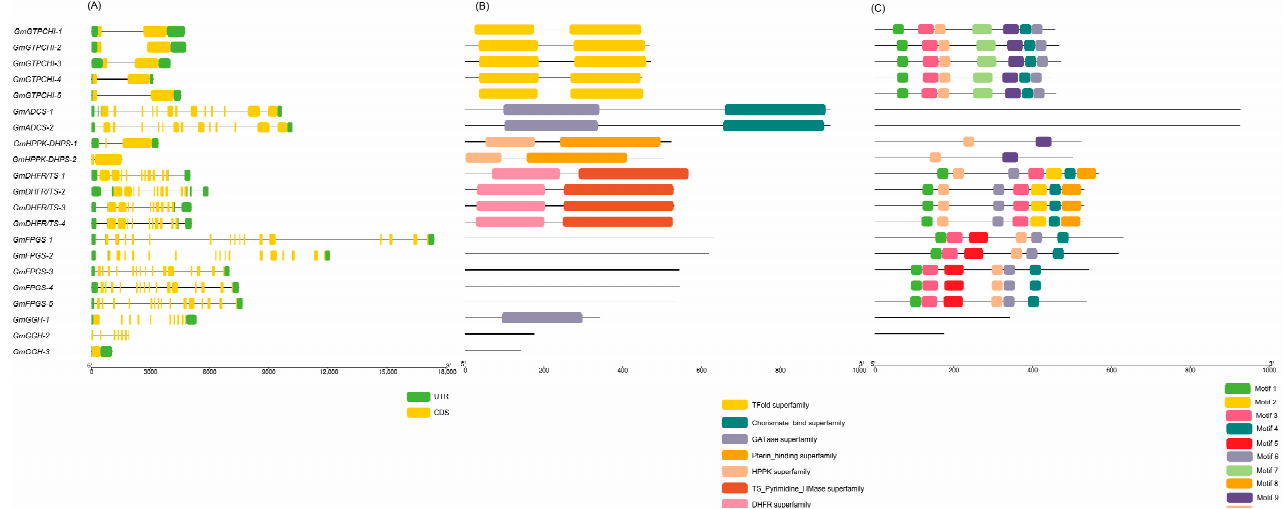
Figure 4. Gene structure ( A ), conserved domains ( B ) and motifs ( C ) of selected soybean folate bio- synthesis genes.